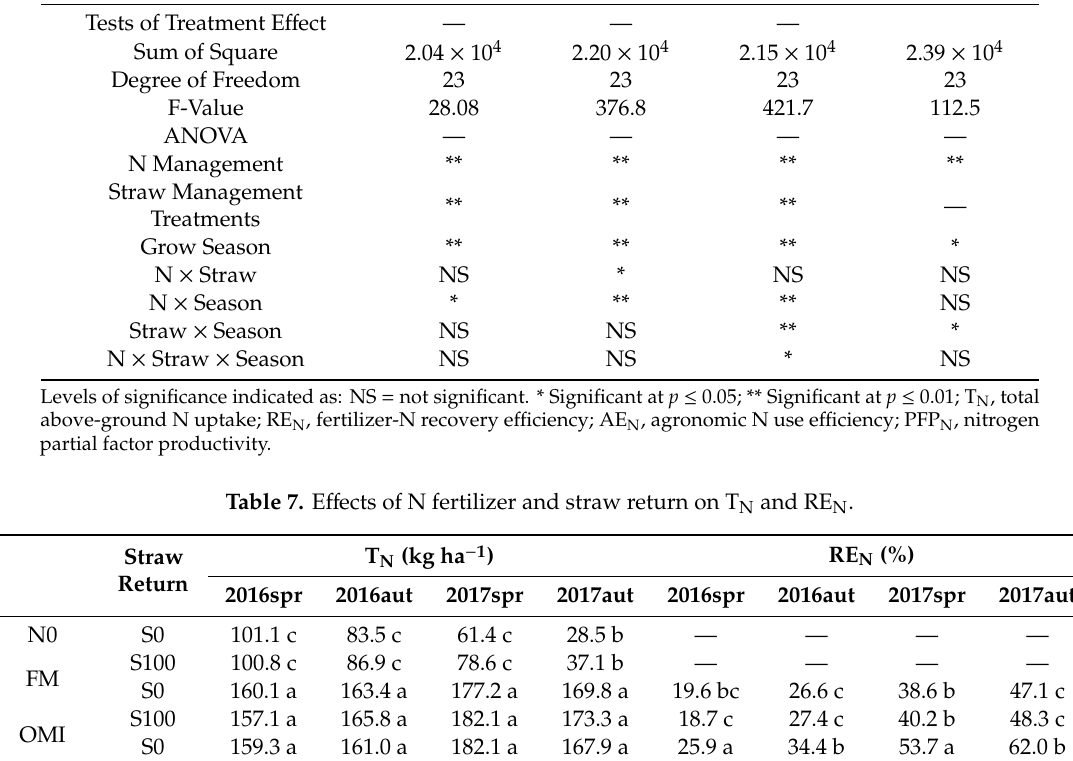
Table 6. Analysis of variance for T N , RE N , AE N , and PFP N of sweet corn. T N RE N AE N PFP N Tests of Treatment E ff ect